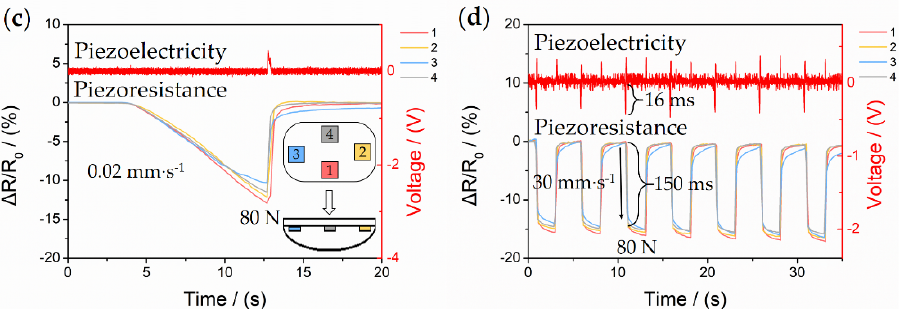
Figure 5. Calibration and performance results. ( a ) Experimental apparatus provides a precise and controllable load to the FMSS. Relationship between resistance responses and applied pressure of ( b ) the original piezoresistive sensors and ( c ) the packaged FMSS. Four different colors represent the load distribution in different locations. ( d ) Piezoelectric and piezoresistive signals generated by a dynamic cycle testing at a load speed of 30 mm/s and a cycle frequency of 0.2 Hz.